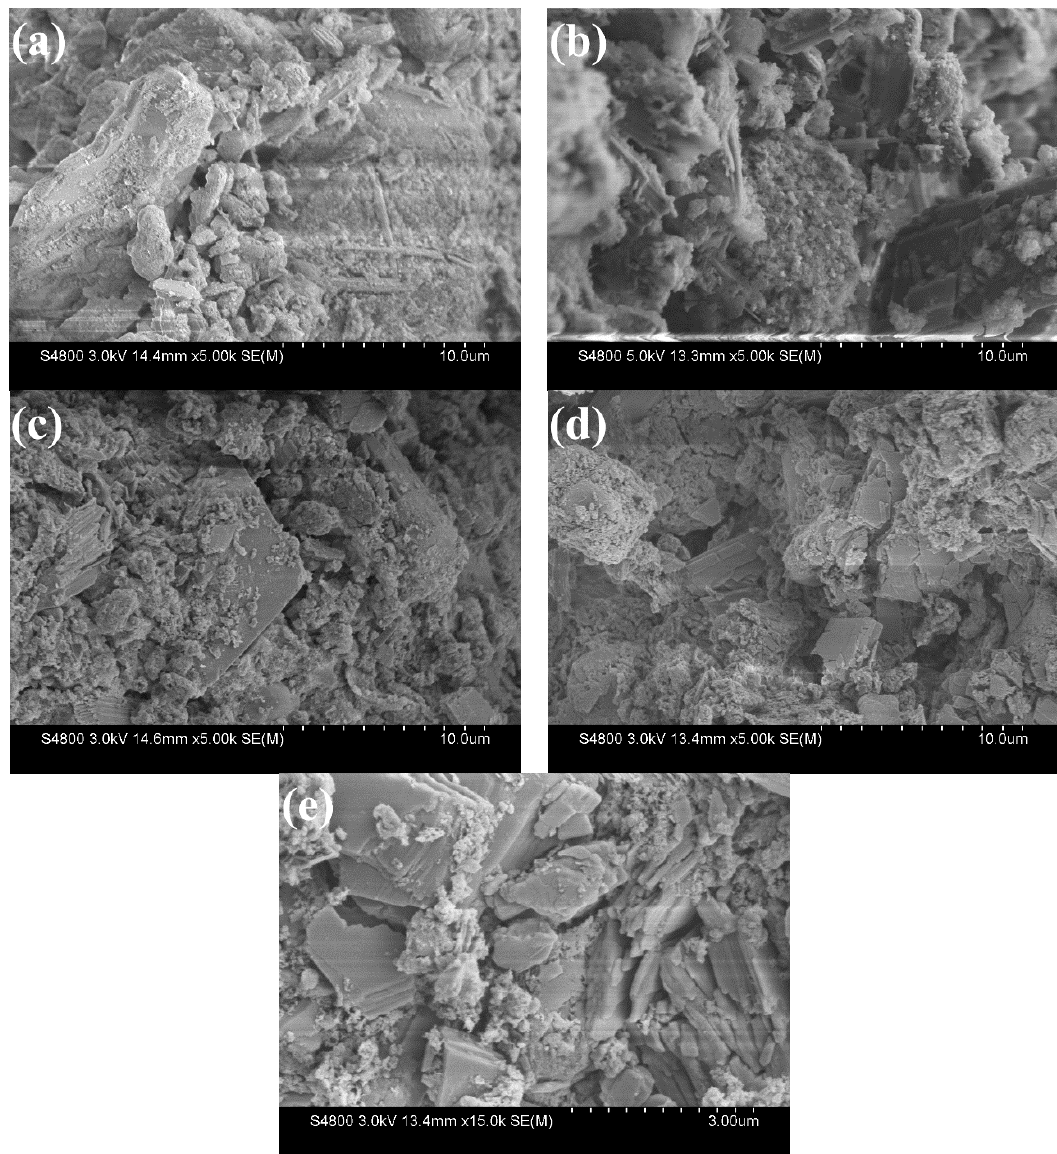
Figure 8. SEM images of C 4 A 3 S pastes without superplasticizers and with superplasticizers for 2 h ( a ) without superplasticizers, ( b ) BNS-0.8%, ( c ) BNS-2.0%, ( d ) PC-0.08%, ( e ) PC-0.20%.